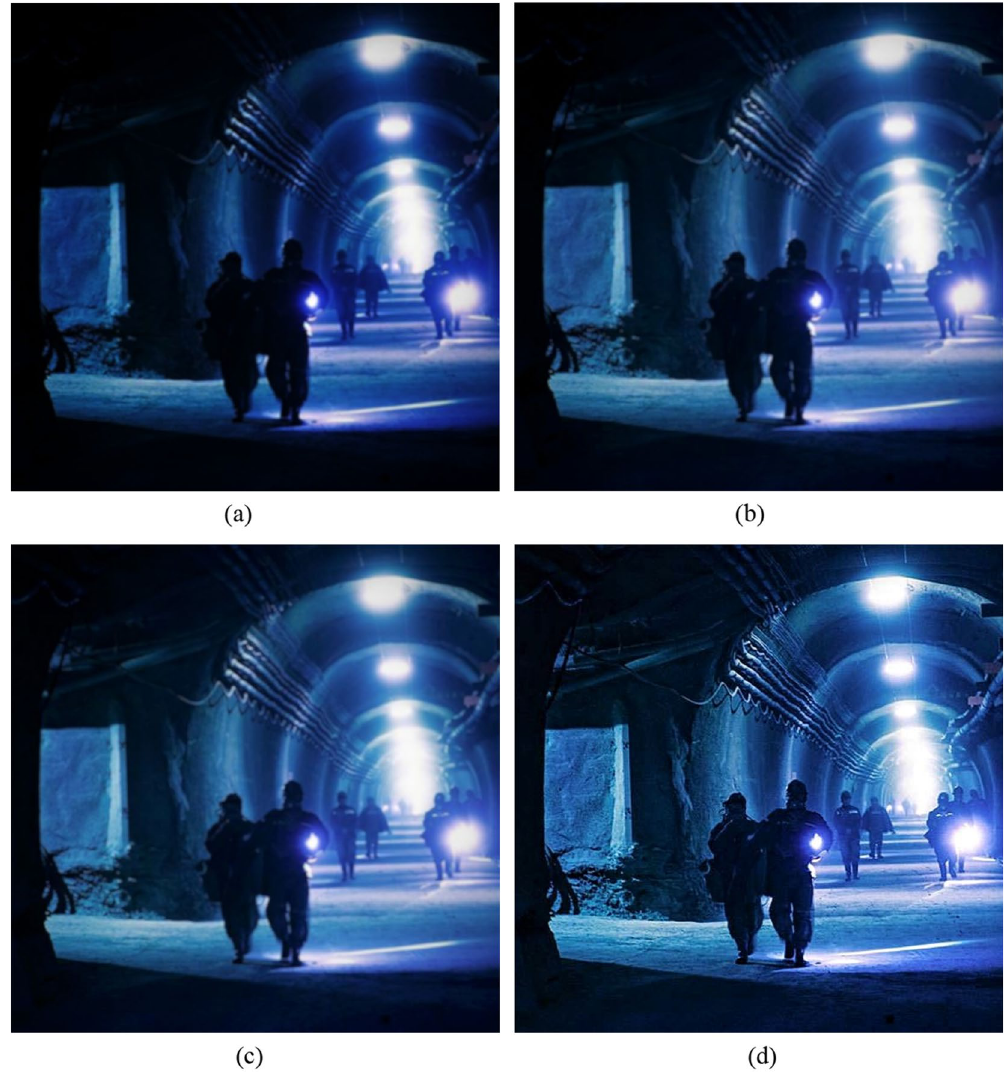
Figure 8. The enhancement effect of the three algorithms on the first set of images in the